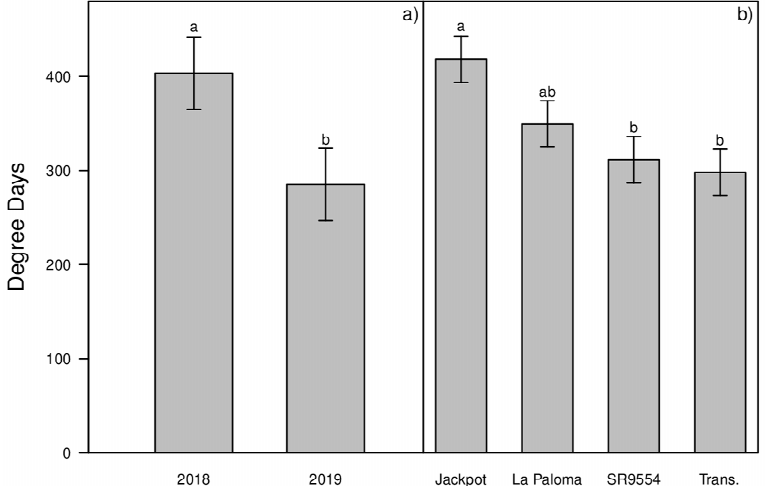
Figure 6. Degree days to reach 75% of green cover (DD) as affected by the main effect of year ( a ) and cultivar ( b ). Trans. = Transcontinental. Values with the same letter are not significantly different (Fisher’s protected LSD test at the 0.05 probability level). Vertical bars represent standard errors.